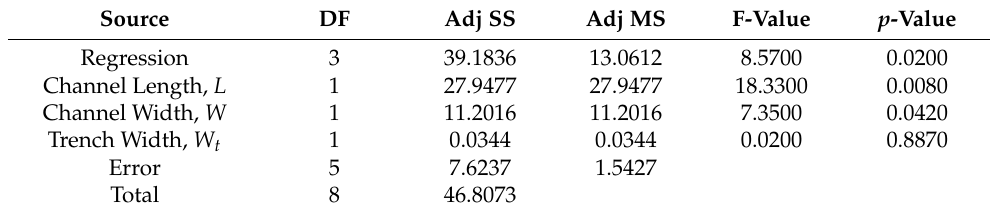
Table 11. Regression ANOVA for the curvature coefficient, γ .